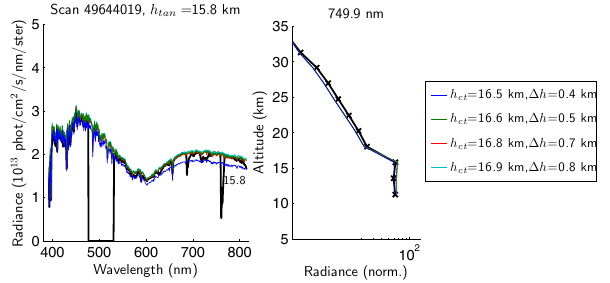
Fig. 8. Modeled in-cloud spectra and radiance profile: varying ver- Fig. 8: Modeled in-cloud spectra and radiance profile: vary- tical thickness and cloud top height. ing vertical thickness and cloud top height. Fig. 8: Modeled in-cloud spectra and radiance profile: vary- ing vertical thickness and cloud top height. Fig. 8: Modeled in-cloud spectra and radiance profile: vary- ing vertical thickness and cloud top height.